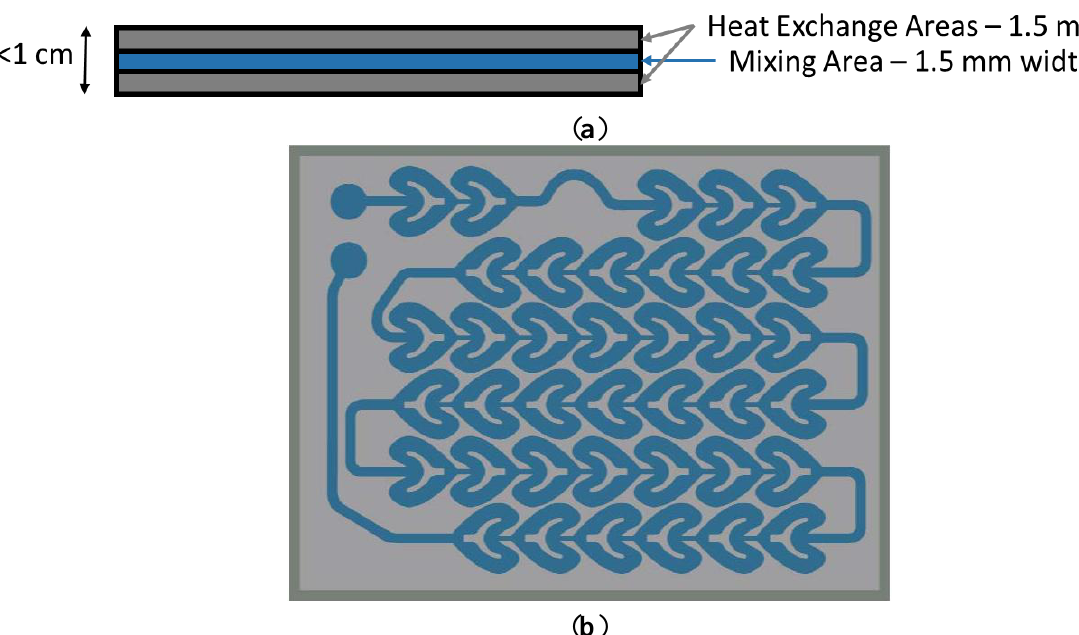
Figure 1. ( a ) Side view of continuous flow reactor mixing chip showing heat exchange and mixing areas. Each area has a width of 1.5 mm, and are separated by 1 mm of glass; ( b ) Top view of continuous flow reactor mixing chip. Heart-shaped mixers are employed to ensure turbulent mixing